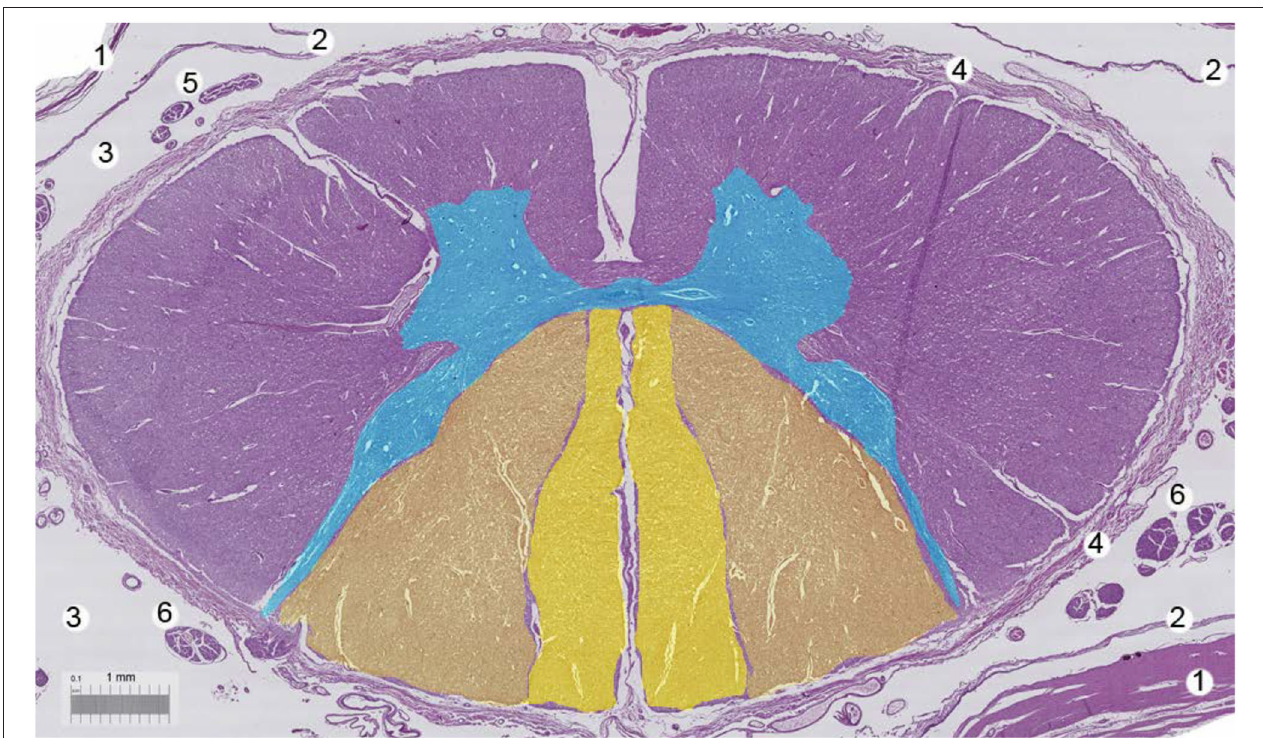
FIGURE 4 | Human spinal cord. Bar, 1mm. 1 = Dura mater, 2 = arachnoid layer, 3 = cerebrospinal fluid, 4 = pia mater, 5 = motor nerve roots, 6 = sensorial nerve roots. With permission of Dr. Miguel A.